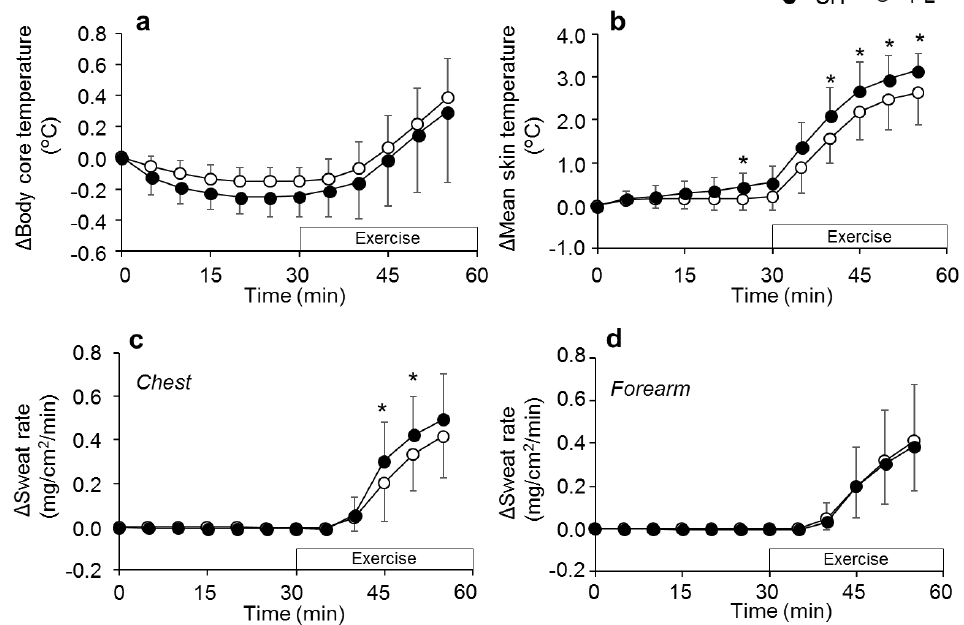
Figure 4. Changes in ( a ) body core temperature ( n = 9), ( b ) mean skin temperature ( n = 8), ( c ) chest sweat rate ( n = 9), and ( d ) forearm sweat rate ( n = 10) following casein hydrolysate (CH) or placebo (PL) ingestions in the main experiment. Values are expressed as mean ± SD. *, P < 0.05.